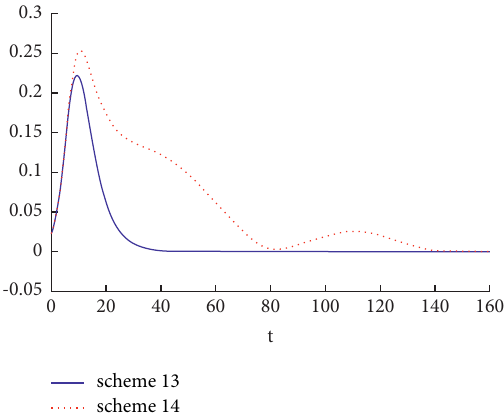
Figure 6: The impact of the conversion rate of β on the population density of spread